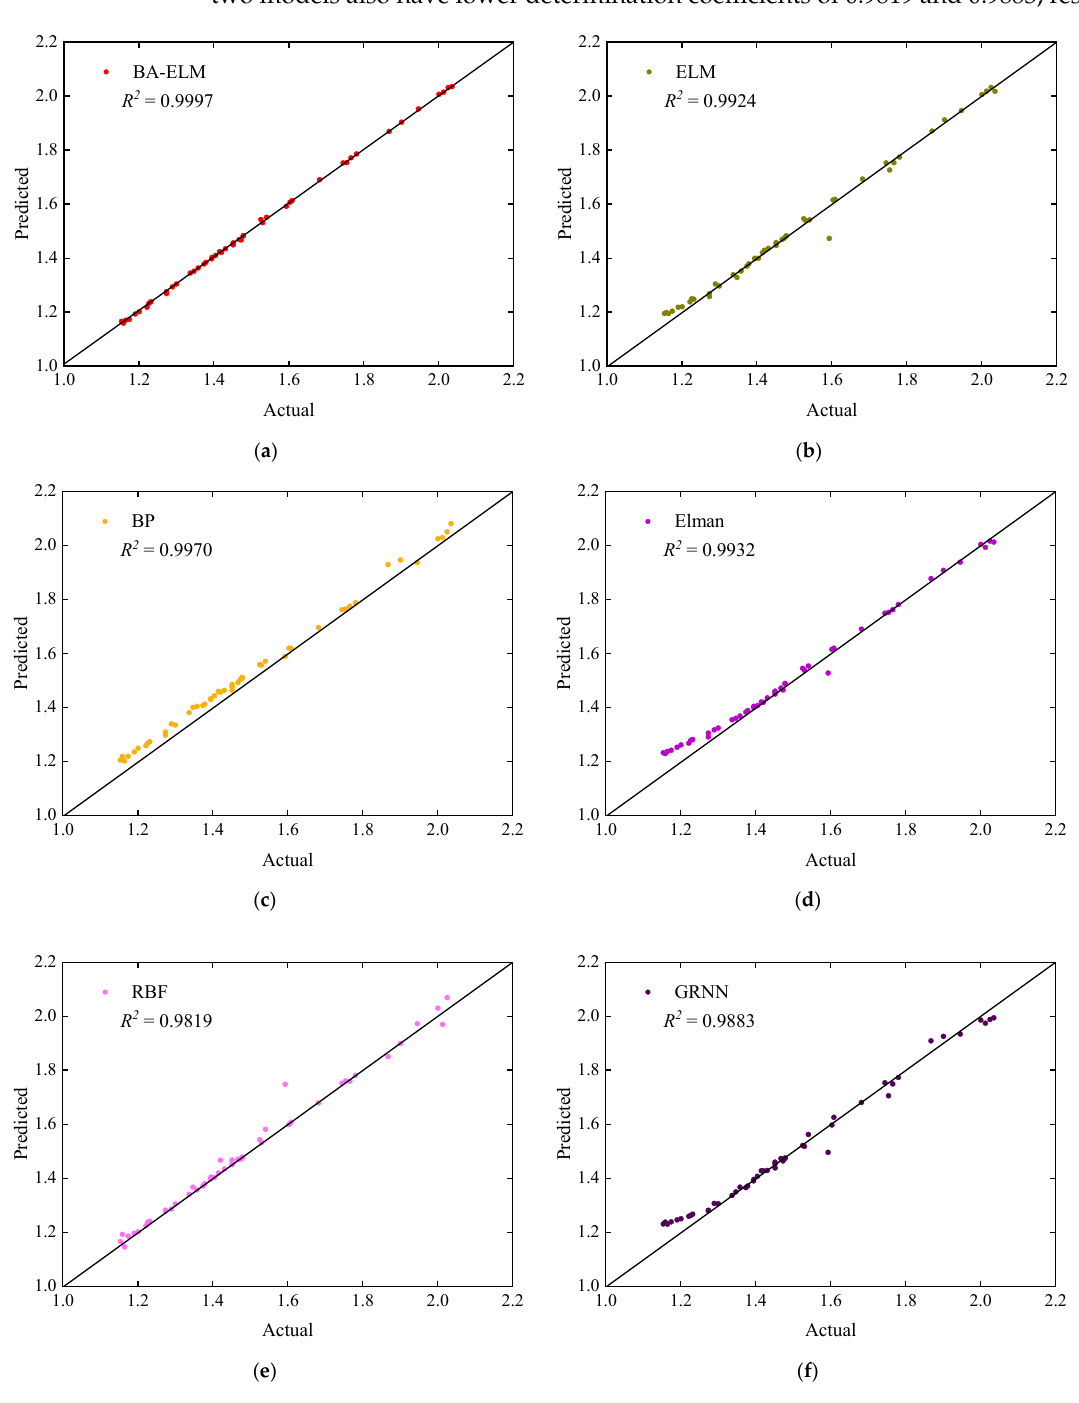
Figure 21. Capacity of actual vs predicted in the form of scatter plot and R 2 , respectively for: ( a ) BA-ELM; ( b ) ELM; ( c ) BP; ( d ) Elman; ( e ) RBF; ( f ) GRNN. In Figure 22, from the violin diagrams, the BA-ELM model demonstrates its advantage by having a distribution that is a more similar distribution to the actual capacity as compared to other models. The data in the BA-ELM model is the most concentrated. A small amount of data in the ELM and RBF models, respectively, is far from the actual value. The median in the BP model is on the high side. A graphical comparison justifies the results obtained using the statistical indicators presented in the previous tables. Based on the above discussion, it can be concluded that compared with the other five models, the BA-ELM model has a better performance and can accurately estimate the actual remaining capacity and SOH of the battery.